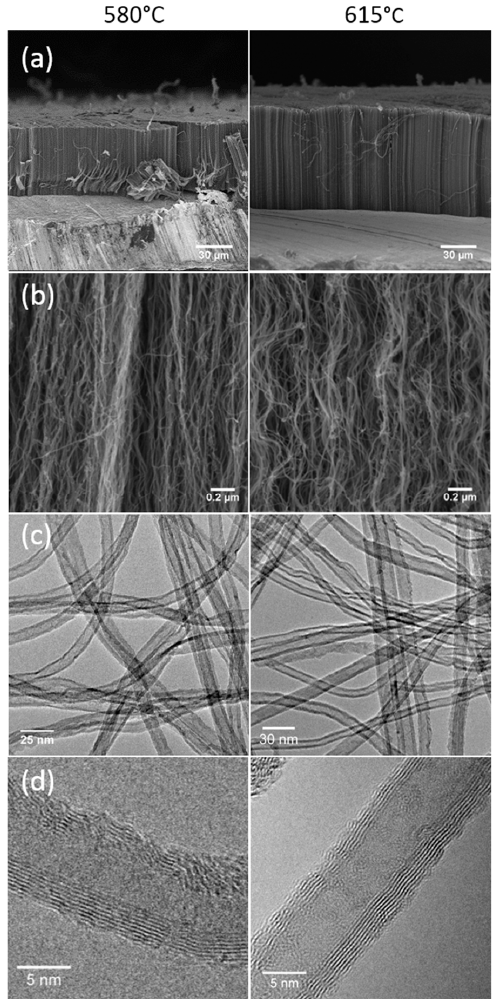
Figure 2. ( a , b ) SEM, ( c ) transmission electron microscopy (TEM) and ( d ) high-resolution TEM (HRTEM) images of VACNT obtained in optimized synthesis conditions at 580 °C (left) and 615 °C (right), respectively.